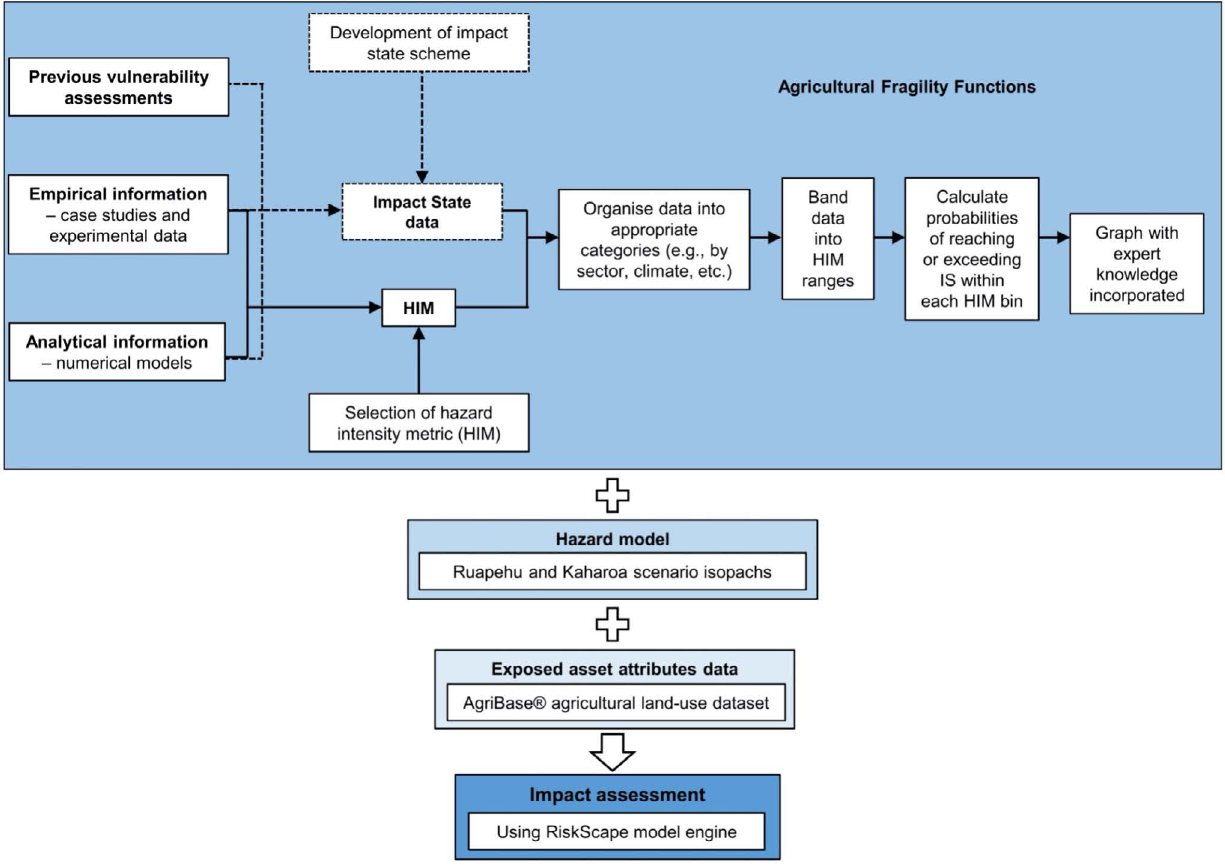
Figure 1: Overview of the process of the creation of fragility functions and the information inputs and components of risk/impact assessments, with the white boxes showing the data and methods applied in this